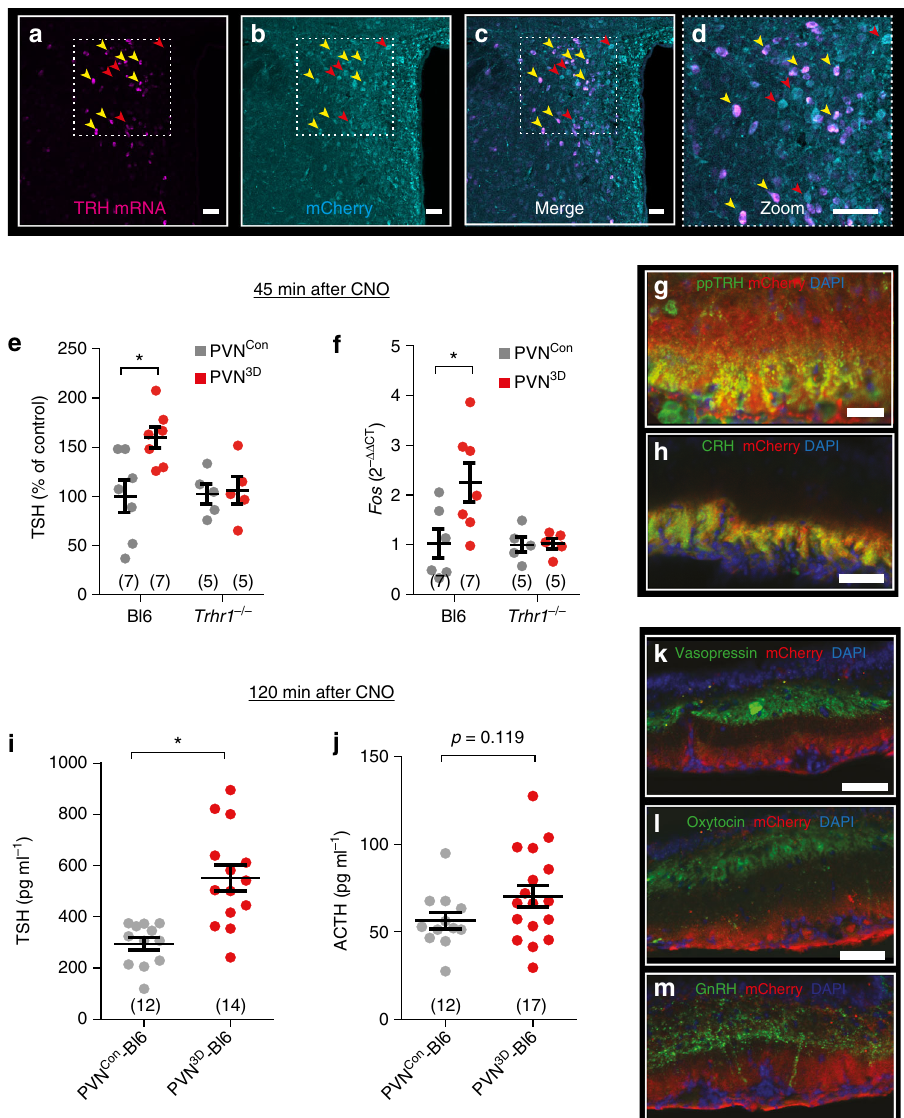
Fig. 6 Chemogenetic activation of hypophysiotropic TRH neurons increases TSH release. a – c Colocalization of Trh mRNA ( a , magenta ) and hM3D-mCherry ( b , cyan ) in the PVN 2 weeks after bilateral injection of AAV-TRH-hM3D-mCherry (PVN 3D ). Cells expressing Trh mRNA were positive for hM3D-mCherry ( yellow arrowheads ; c and d ). Red arrowheads label hM3D-mCherry-positive cells without Trh mRNA expression; scale bar , 50 µ m. e Plasma TSH concentrations 45 min after CNO administration to Trhr1 + / + (Bl6) and littermate Trhr1 − / − mice without (PVN Con , gray ) and with injection of AAV-TRH- hM3D-mCherry into the PVN (PVN 3D , red ). TSH plasma concentrations are shown as percentage of Bl6 for normalization, because of a slight but non- signi fi cant increase of TSH in Trhr1 − / − compared to Bl6 mice. Two-way ANOVA for genotype: F(1/20) = 5.3, p = 0.032; * p < 0.05 (Bonferroni post test); mean ± S.E.M.; n as indicated. f Relative change in Fos mRNA expression (2 − ΔΔ CT ) in the pituitary 45 min after CNO administration to Bl6 and Trhr1 − / − mice without (PVN Con , gray ) and with injection of AAV-TRH-hM3D-mCherry into the PVN (PVN 3D , red ). Two-way ANOVA for genotype: F(1/19) = 4.4, p = 0.049; * p < 0.05 (Bonferroni post test); mean ± S.E.M.; n as indicated. g and h Two weeks after bilateral injection of AAV-TRH-hM3D-mCherry (PVN 3D ) in the PVN of C57Bl/6 mice (PVN 3D -Bl6) hM3D-mCherry-positive fi bers were detected in the ME. g Colocalization of hM3D-mCherry with ppTRH in fi bers of the ME ( red , hM3D-mCherry; green , ppTRH; blue , DAPI; scale bar , 50 µ m). h Colocalization of hM3D-mCherry with CRH in fi bers of the ME ( red , hM3D-mCherry; green , CRH; blue , DAPI; scale bar , 50 µ m). i Plasma TSH concentrations 2 h after CNO stimulation of PVN Con -Bl6 ( gray ) and PVN 3D -Bl6 ( red ) mice. * p = 0.0002 (two-tailed Student ’ s t -test); mean ± S.E.M.; n as indicated. j Plasma ACTH concentrations 2 h after CNO stimulation of PVN Con -Bl6 ( gray ) and PVN 3D -Bl6 ( red ) mice. p = 0.11 (Student ’ s t -test); mean ± S.E.M; n as indicated. k – m No colocalization of hM3D-mCherry with vasopressin ( green , j ), oxytocin ( green , k ), or GnRH ( green , l ) in fi bers of the ME. Red , hM3D-mCherry; blue , DAPI; scale bar , 50 µ